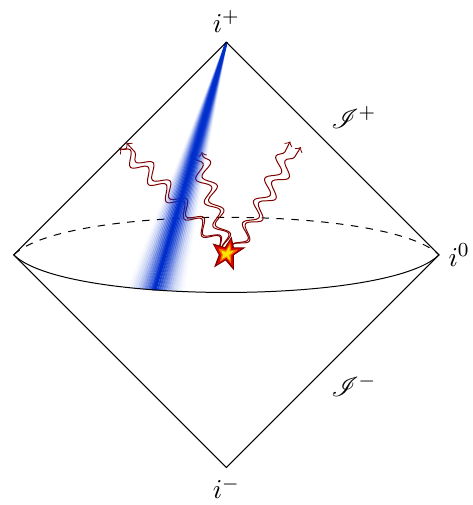
Figure 1. A detector (blue) is a translationally-invariant operator localized at future null infinity I + , capable of measuring properties of a state at late times. Some detectors, such as the average null energy operator E 2 ( ~n ) , are localized on a light-ray. Other detectors can measure nontrivial angular distributions on the celestial sphere, as indicated by “fuzziness” in the angular directions in the